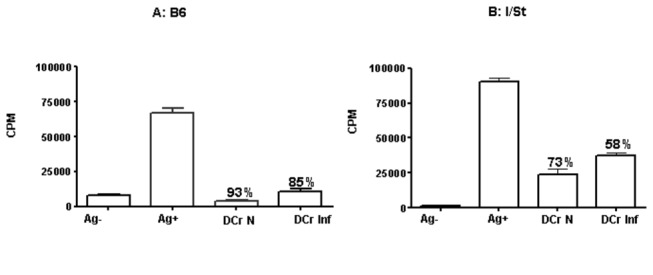
DCreg developed on lung stroma from naïve (N) TB-resistant (A) B6 mice are more potent inhibitors of T cell response than their counterparts from TB-susceptible (B) I/St mice (P<0.01, ANOVA).Inhibitory activity of DCreg developed on stromal cells from infected (Inf) animals was almost fully retained in B6 (A), but significantly (P<0.05, ANOVA) dropped in I/St mice (B). Mean triplicate CFU counts ± SD from 4 independent experiments and per cent of inhibition are displayed.